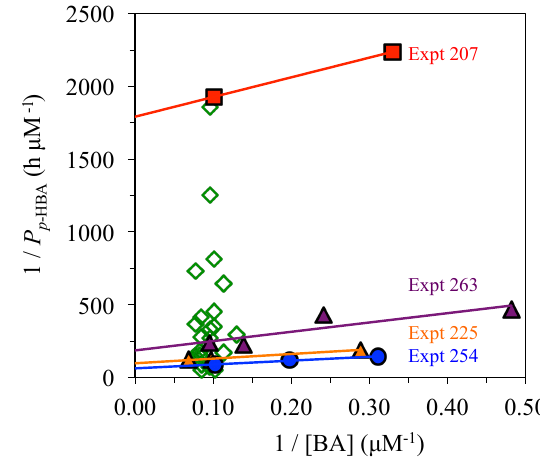
Figure 6. Measurements of • OH in Summit snow samples stud- ied in the field, including four samples studied with multiple BA concentrations (with experiment number listed). Green hollow dia- monds represent the 34 other snow samples that were studied using just one BA